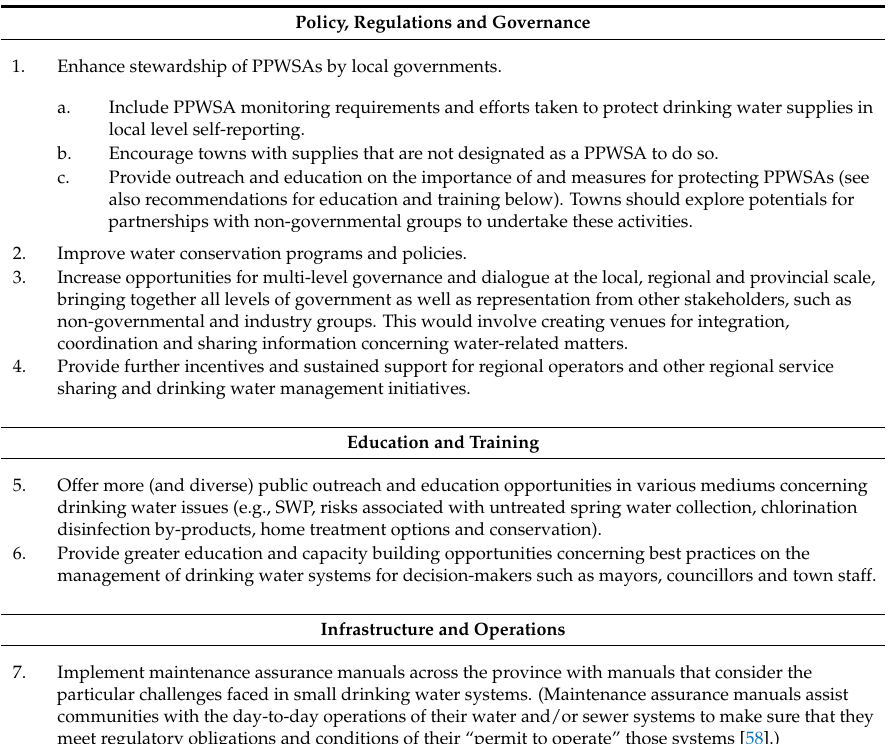
Table 3. Source water protection report recommendations (from [19], pp.